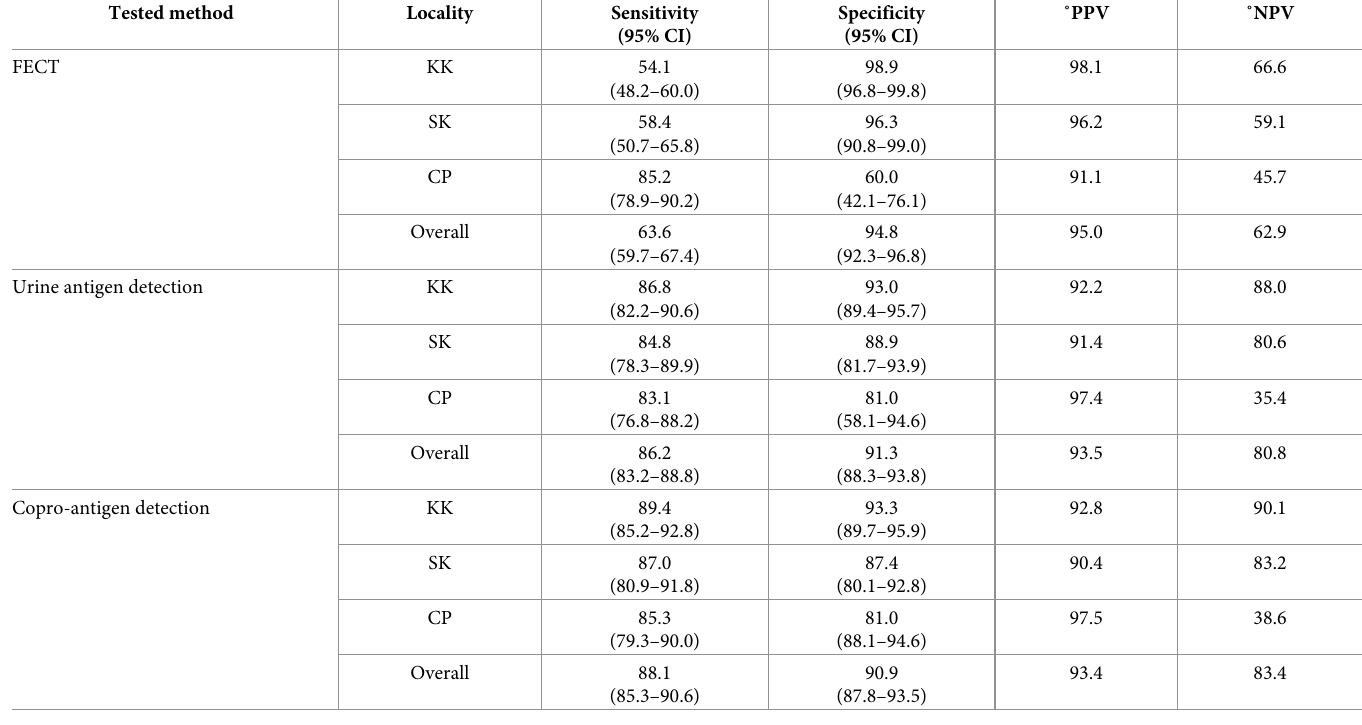
Table 4. Diagnostic performance of antigen detection methods for urine and copro-antigen compared with the composite gold standard which combined FECT and antigen detection method. Tested